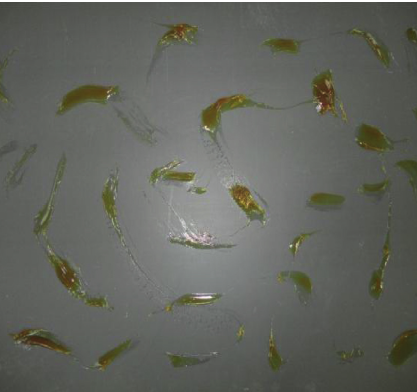
Figure 5: Simulation of stick-slip fault dislocation effect.